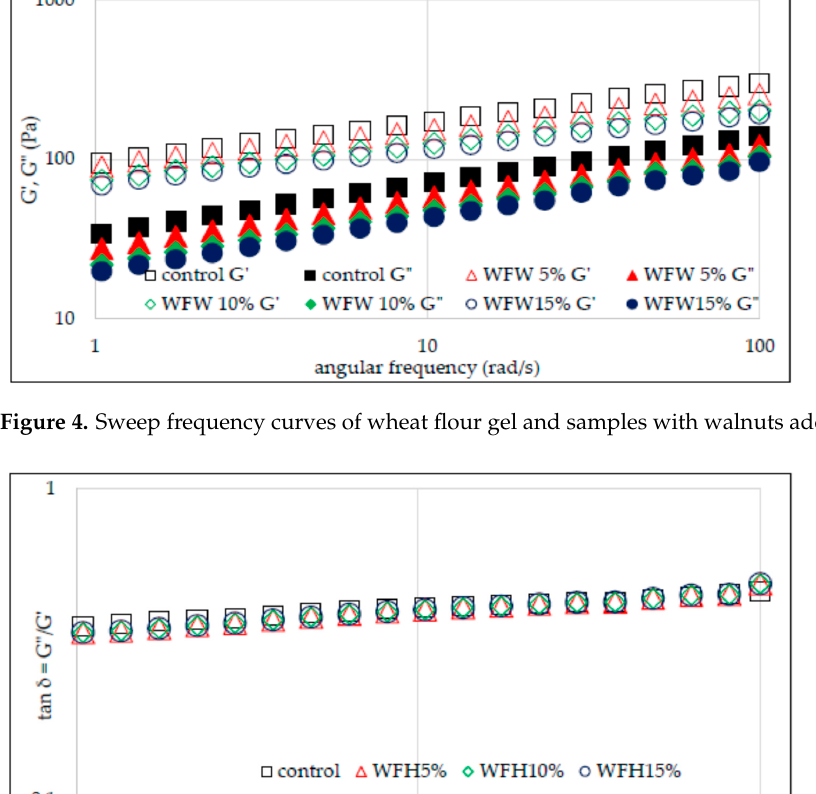
Figure 6. Tangent δ depending on the angular frequency of wheat flour gel and samples with wal- nuts addition.